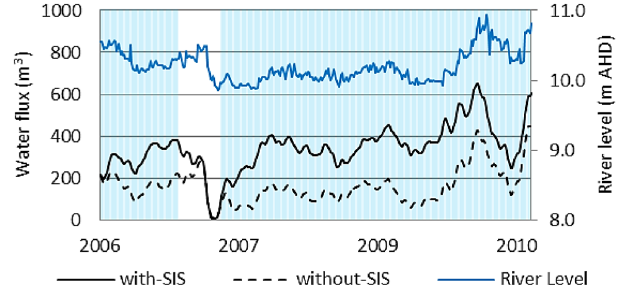
Fig. 10. Cumulative evaporation from the floodplain aquifer for the defined